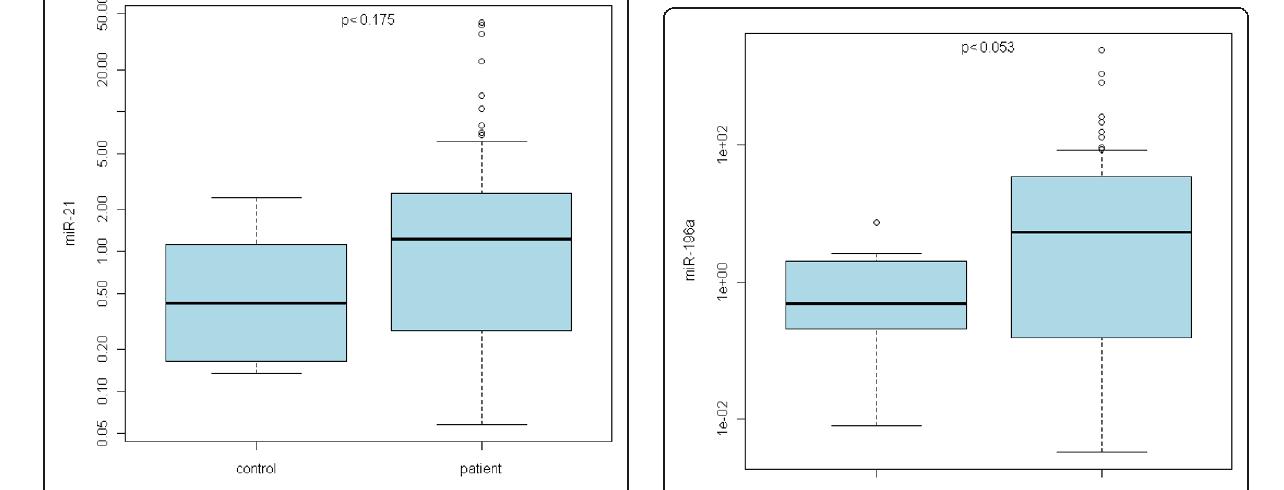
Figure 1 miRNA-21 expression in normal healthy esophagus vs Barrett ’ s metaplasia . No statistically significant differences in miR- 21 expression were observed.